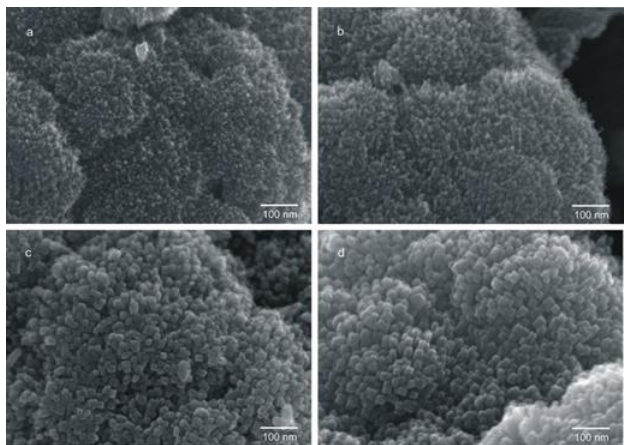
Figure 3. High-resolution scanning electron microscopy (SEM) micrographs of flower-like rutile TiO 2 (FLH-R- TiO 2 ): ( a ) FLH-R-TiO 2 /AP (as prepared), ( b ) FLH-R-TiO 2 /150, ( c ) FLH-R-TiO 2 /200 and ( d ) FLH-R-TiO 2 /250. TiO 2 (FLH-R-TiO 2 ): ( a ) FLH-R-TiO 2 / AP (as prepared), ( b ) FLH-R-TiO 2 / 150, ( c ) FLH-R-TiO 2 / 200 and Reprinted from ref. [25], Copyright (2016), with permission from Elsevier. ( d ) FLH-R-TiO 2 / 250. Reprinted from ref. [25], Copyright (2016), with permission from